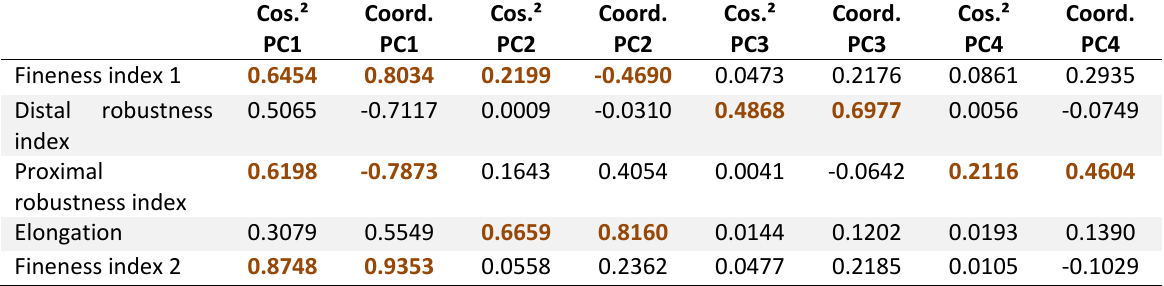
Table 9. Coordinates of the first four PCs and their cos 2 from the PCA5 presented in Figure 16. Variables with the highest contribution and quality of representation on the PCs are shown in